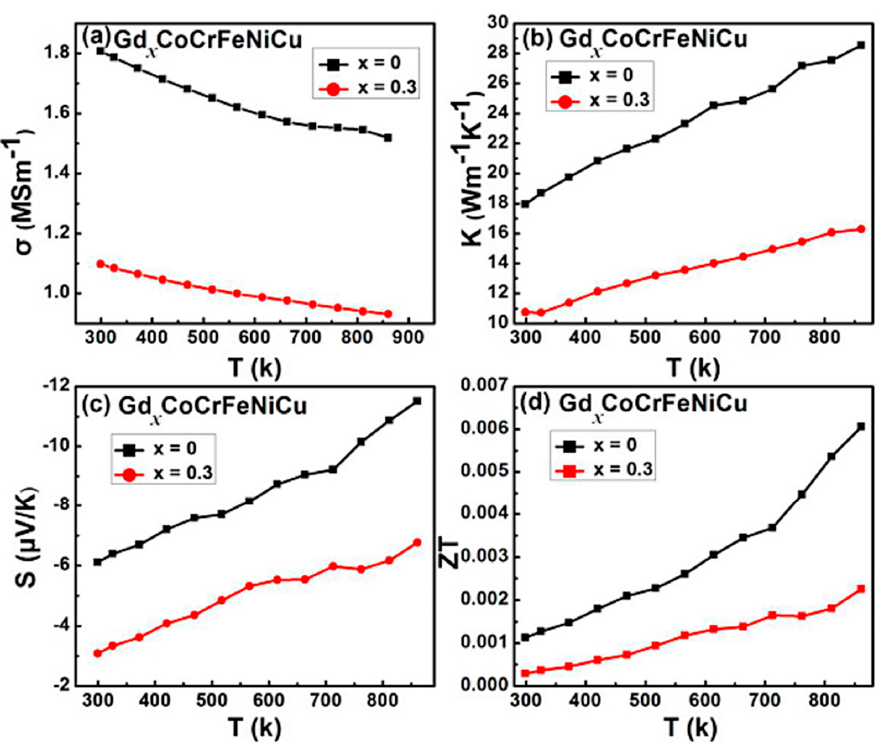
Figure 6. Thermoelectric properties of the Gd x CoCrFeNiCu alloy. ( a ) Electrical conductivity; ( b ) Thermal conductivity; ( c ) Seebeck coefficient; ( d ) Figure of merit,